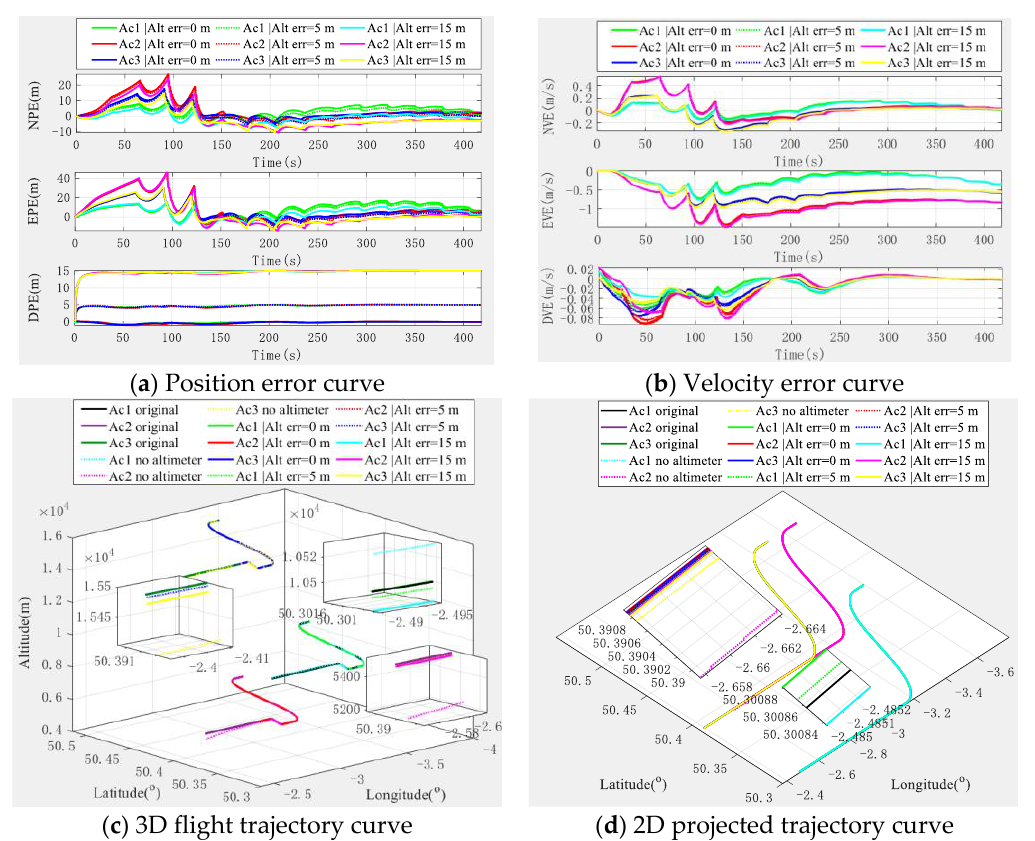
Figure 8. Navigation and positioning error curve of multi-aircraft cooperative navigation in the DWAPC-TSM system with the aid of an altimeter.